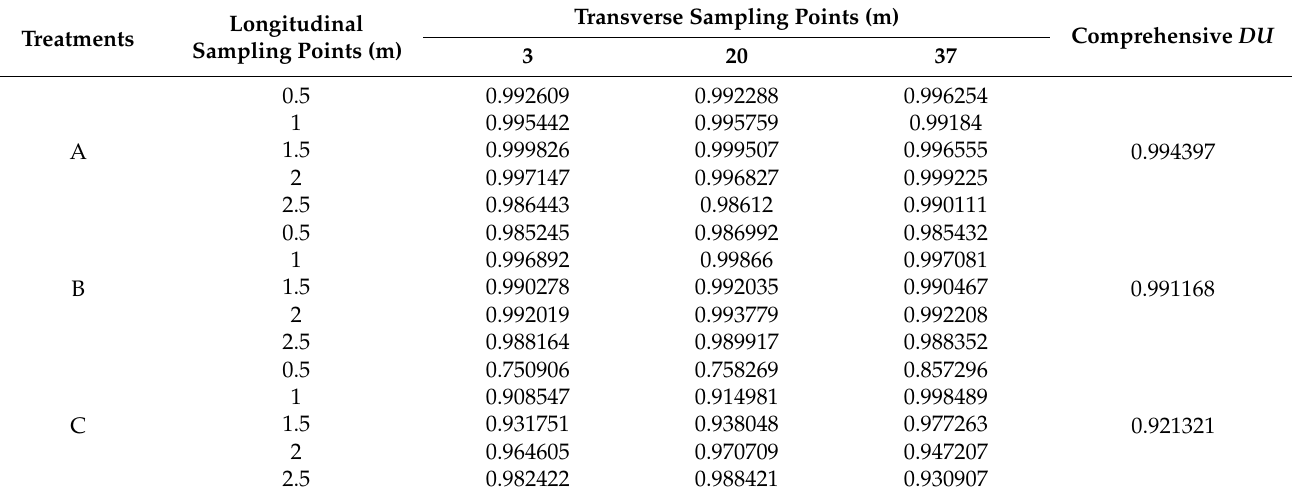
Table 3. Comprehensive distribution